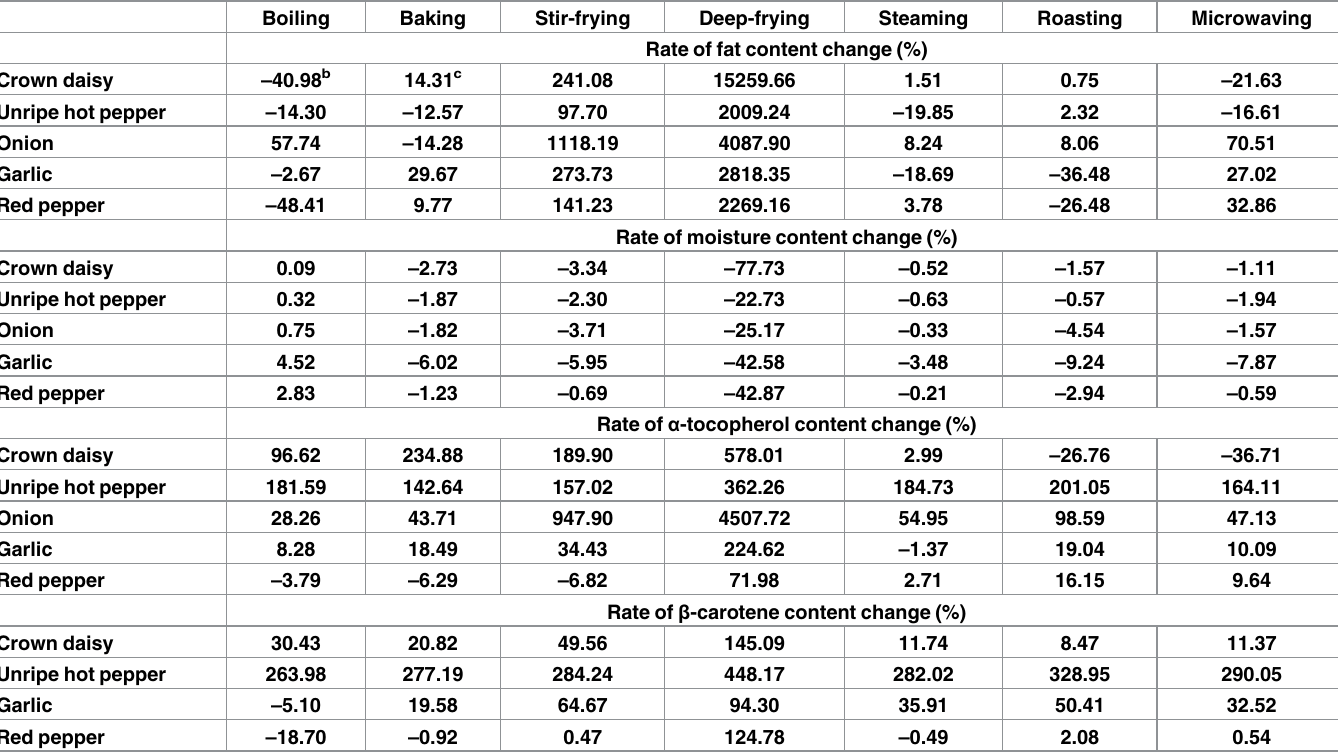
Table 4. Effect of different cooking methods on the percent variation of fat, moisture, α -tocopherol and β -carotene contents in 5 spices a .